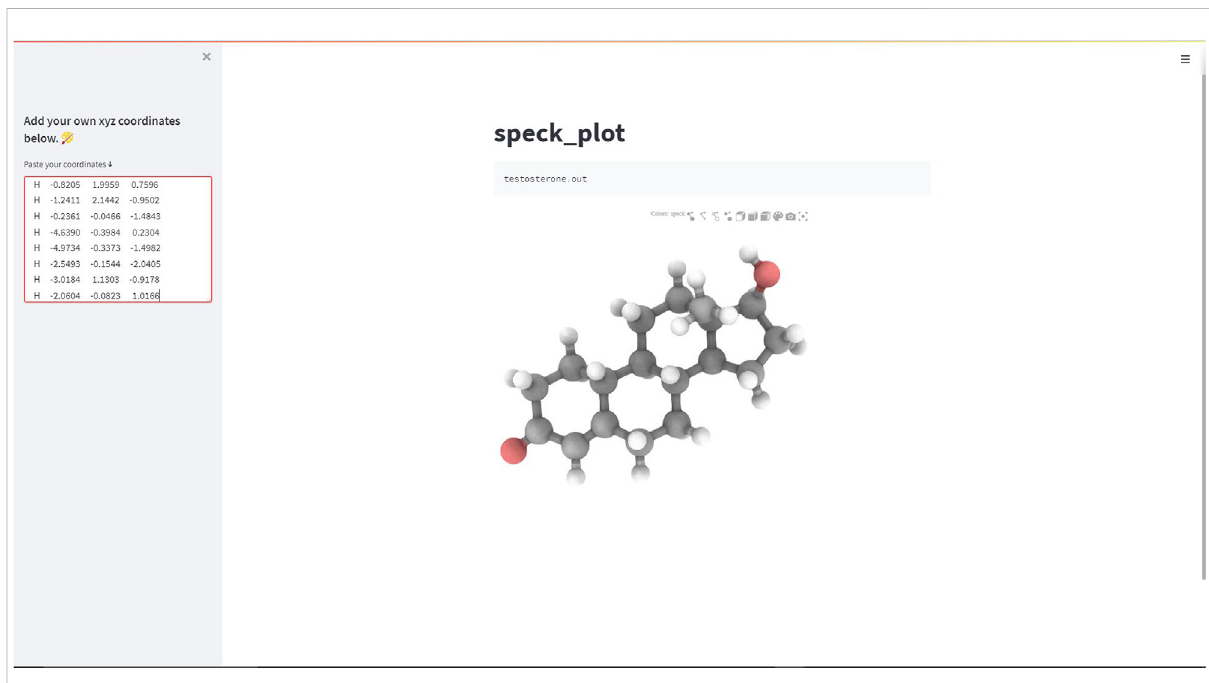
FIGURE 4 Screen-capture of the Streamlit web-app demonstrating the speck-plot rendering